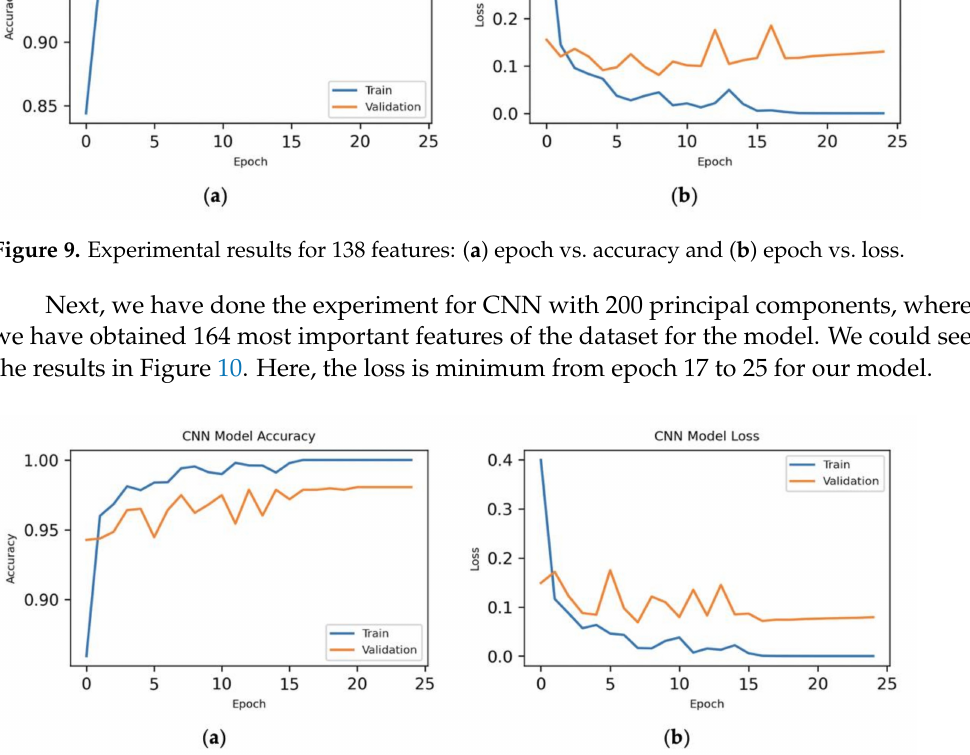
Figure 10. Experimental results for 164 features: ( a ) epoch vs. accuracy and ( b ) epoch vs. loss.